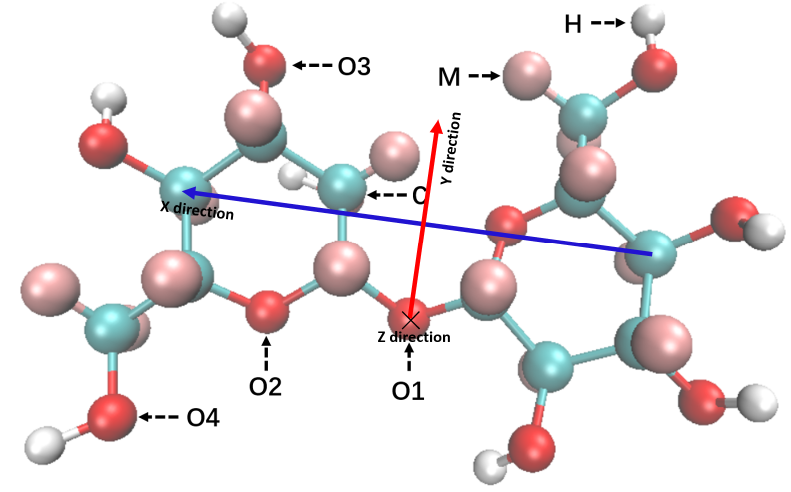
Figure 1. Structure of a trehalose molecule and its atomic labels used in EPSR simulation. All carbon atoms are labeled as C; all hydrogen atoms connected to the oxygen atom are labeled as H; the remaining hydrogen atoms connected to the carbon atom are labeled as M; the oxygen atom linking the two glucose rings is labeled as O1; the oxygen atoms on the glucose ring is labeled as O2; the oxygen atoms on the hydroxyl group connected to the glucose ring are labeled as O3; and the oxygen atom on the methyl group is labeled as O4. In order to describe the distribution of atoms around trehalose with spatial angles, we set up a coordinate system with O1 as the coordinate origin. The blue arrow connecting two C atoms at the glucose rings represents the direction of the X -axis; the red arrow pointing vertically to the blue arrow from O1 is the direction of the Y -axis; the Z -axis is the cross product of the X -axis and the Y -axis, which is approximately perpendicular to the paper. Table 2. Lennard-Jones (L-J) reference potential parameters and charge (q) of atoms used in EPSR. ( 1 ) Atom Label